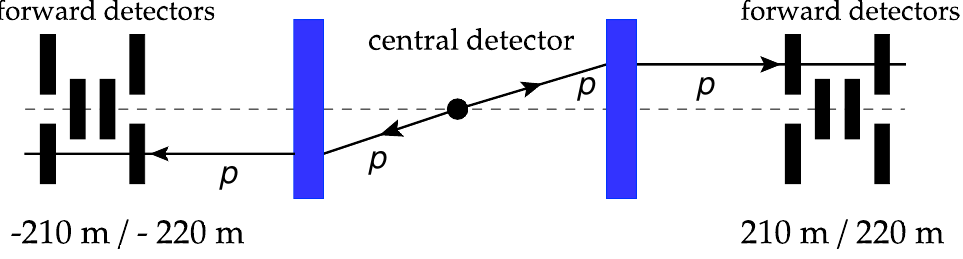
Figure 2 . Schematic diagram of the proton tagging method at the LHC in central exclusive processes. The central detector (circle) collects the photon pair. The LHC magnets (blue) act as a precise momentum spectrometer on the outgoing intact protons. The protons pass through the forward detectors (black boxes) and their kinematic information is reconstructed o(cid:15)ine. The dashed line represents the